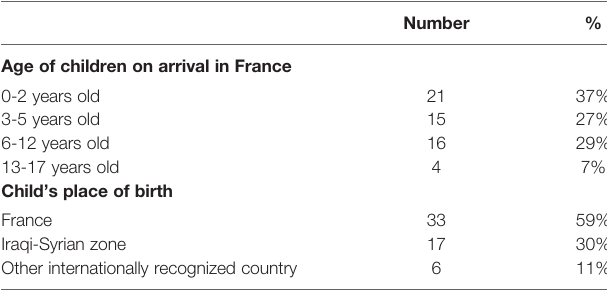
TABLE 2 | Demographic characteristics of the 56 children referred to the psychopathology department of Avicenne Hospital between March 2017 and